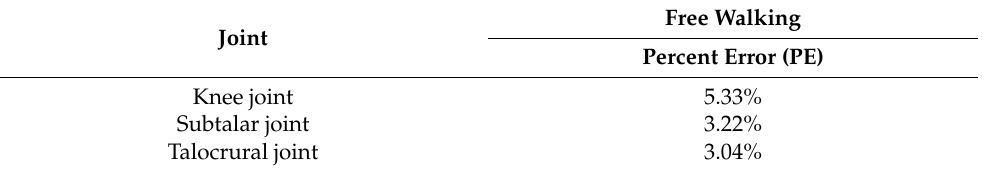
Table 12. Percent error (PE) of angle estimation simulation according to free walking.